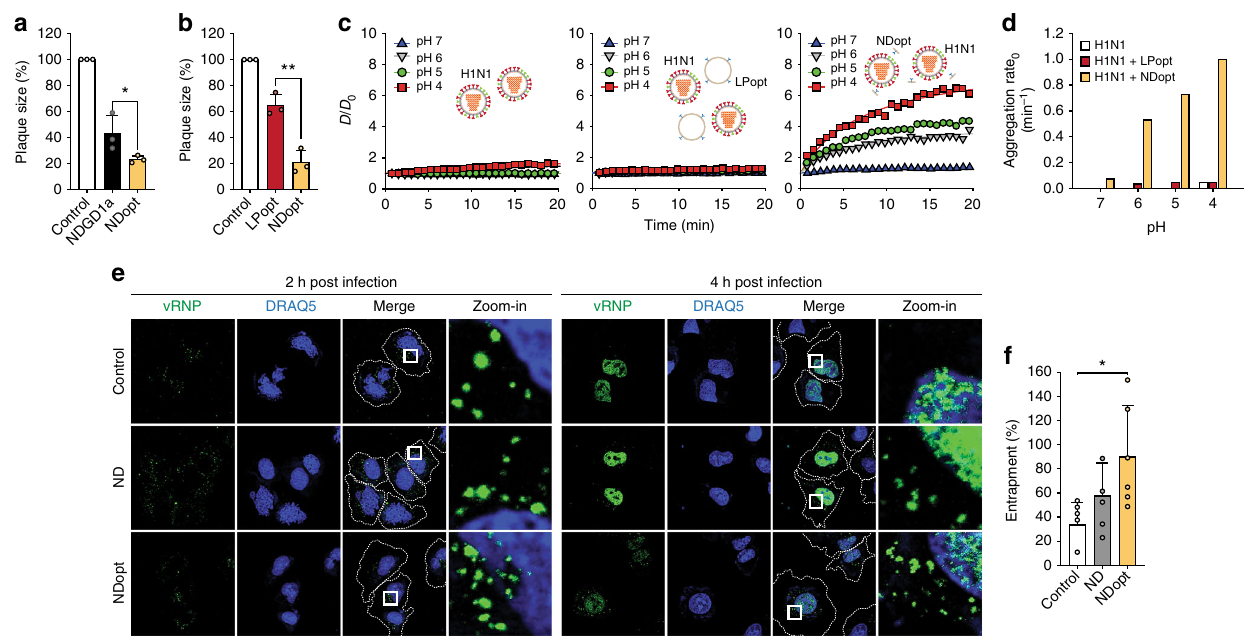
Fig. 4 Abortive vRNP release in the endolysosome by NDopt. a , b Antiviral activity against H1N1 virus of NDopt compared with NDGD1a (50 nM) ( a ) or liposomes with the same lipid composition as NDopt (LPopt) (12.5 μ M lipid) ( b ) was examined by a plaque assay ( n = 3). c , d Aggregation of NDopt- disrupted viruses was monitored by measuring the changes in the average size of samples as a function of time. c Time-dependent changes in the diameter of H1N1 virus only (left panel), mixture of H1N1 and LPopt (middle panel) and mixture of H1N1 and NDopt (right panel). H1N1 virus (1 × 10 7 PFU/mL) was mixed with PBS, LPopt (2.5 μ M for lipid) or 16.6 nM NDopt. Changes in the diameter were monitored using a Zetasizer (Nano ZS90, Malvern Instruments, Ltd., Worcestershire, UK) and expressed as D / D 0 , where D 0 and D are the averaged diameters of samples before and after vhjpH adjustment, respectively. d Aggregation rate 0 , calculated from the slope of D / D 0 at the beginning of the aggregation reaction, suggests that viral envelope is ef fi ciently disrupted by nanodiscs. e In fl uenza virus vRNP entrapment in endosome by NDopt. White squares in merge panels are enlarged to show virus entrapment (green) near the nucleus (blue) (zoom-in). Cell membranes shown as white dashed lines. Scale bars, 10 μ m. f Quantitation of viral entrapment, which was calculated by dividing the number of vRNP spots in the endosome at 4 h post-infection by the number of vRNP spots at 2 h post-infection ( n = 5). Data are expressed as the mean ± SD. Asterisks indicate statistical signi fi cance determined by Student ’ s t -test (* P < 0.05; ** P < 0.01; *** P < 0.001) ( a , b , f